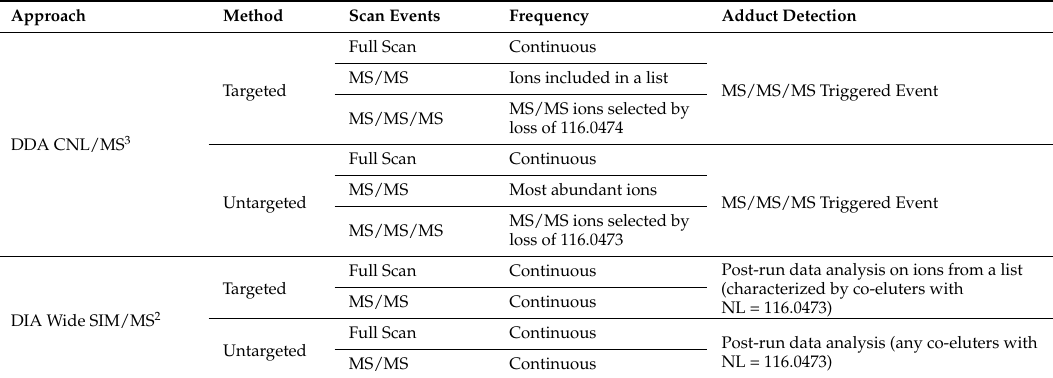
Table 1. Summary of MS 2 − 3 data dependent acquisition (DDA) and MS 2 data independent acquisition (DIA) scanning